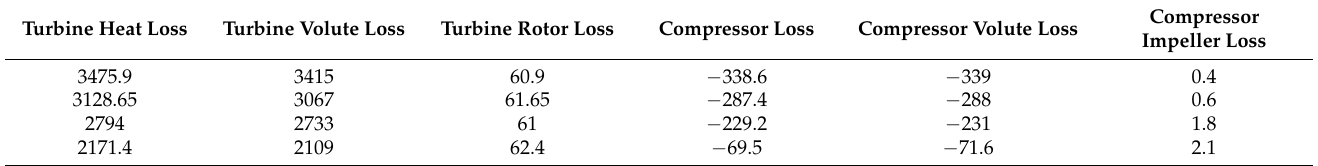
Table 8. Heat loss in the turbine and compressor (all units in